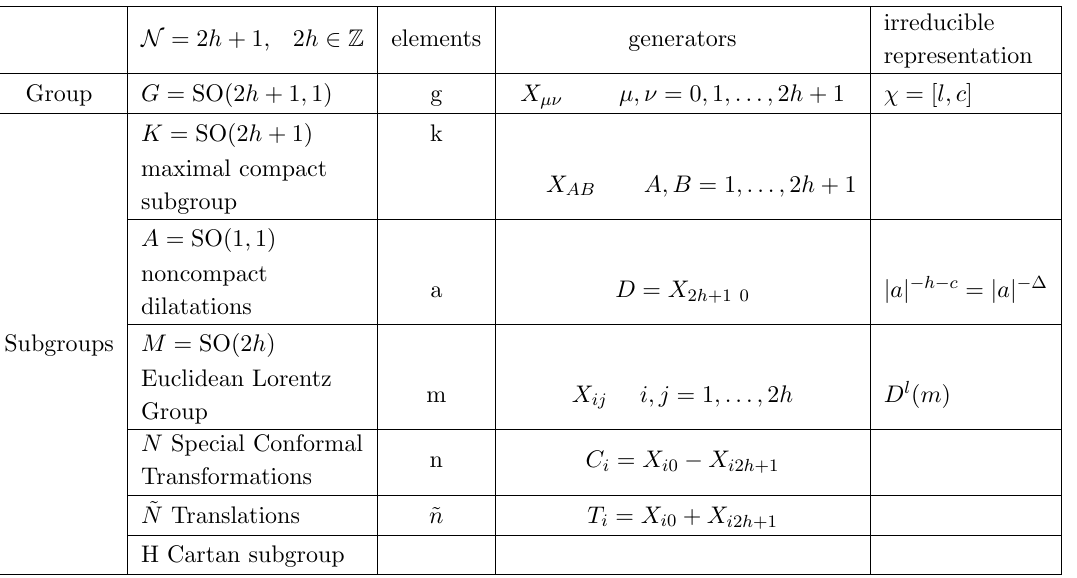
Table 1 . The subgroups of SO(2 h + 1 ;